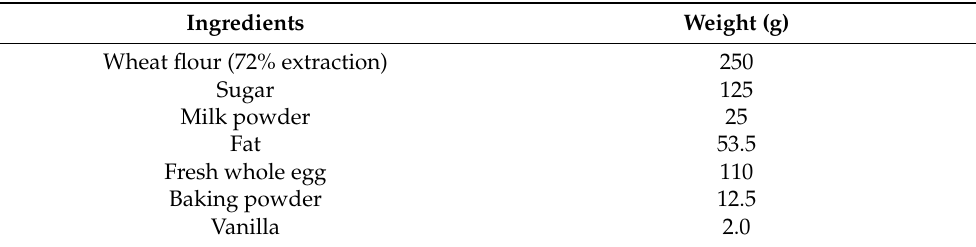
Table 1. Raw ingredients of processed cakes according to Zaker et al. [65].